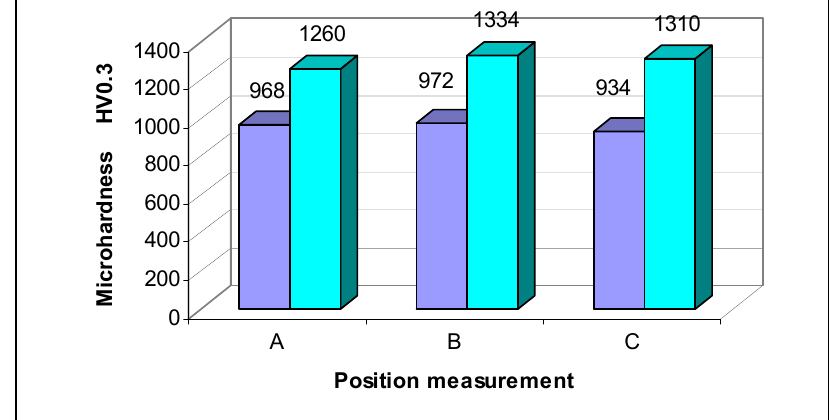
Figure 2 – The microhardness of the Mo&O2 coating, the measurement positions Рис . 2 – Микротвердость покрытия Mo&O2 в точках измерения Слика 2 – Микротврдоће превлаке Mo&O2 на позицијама мерења